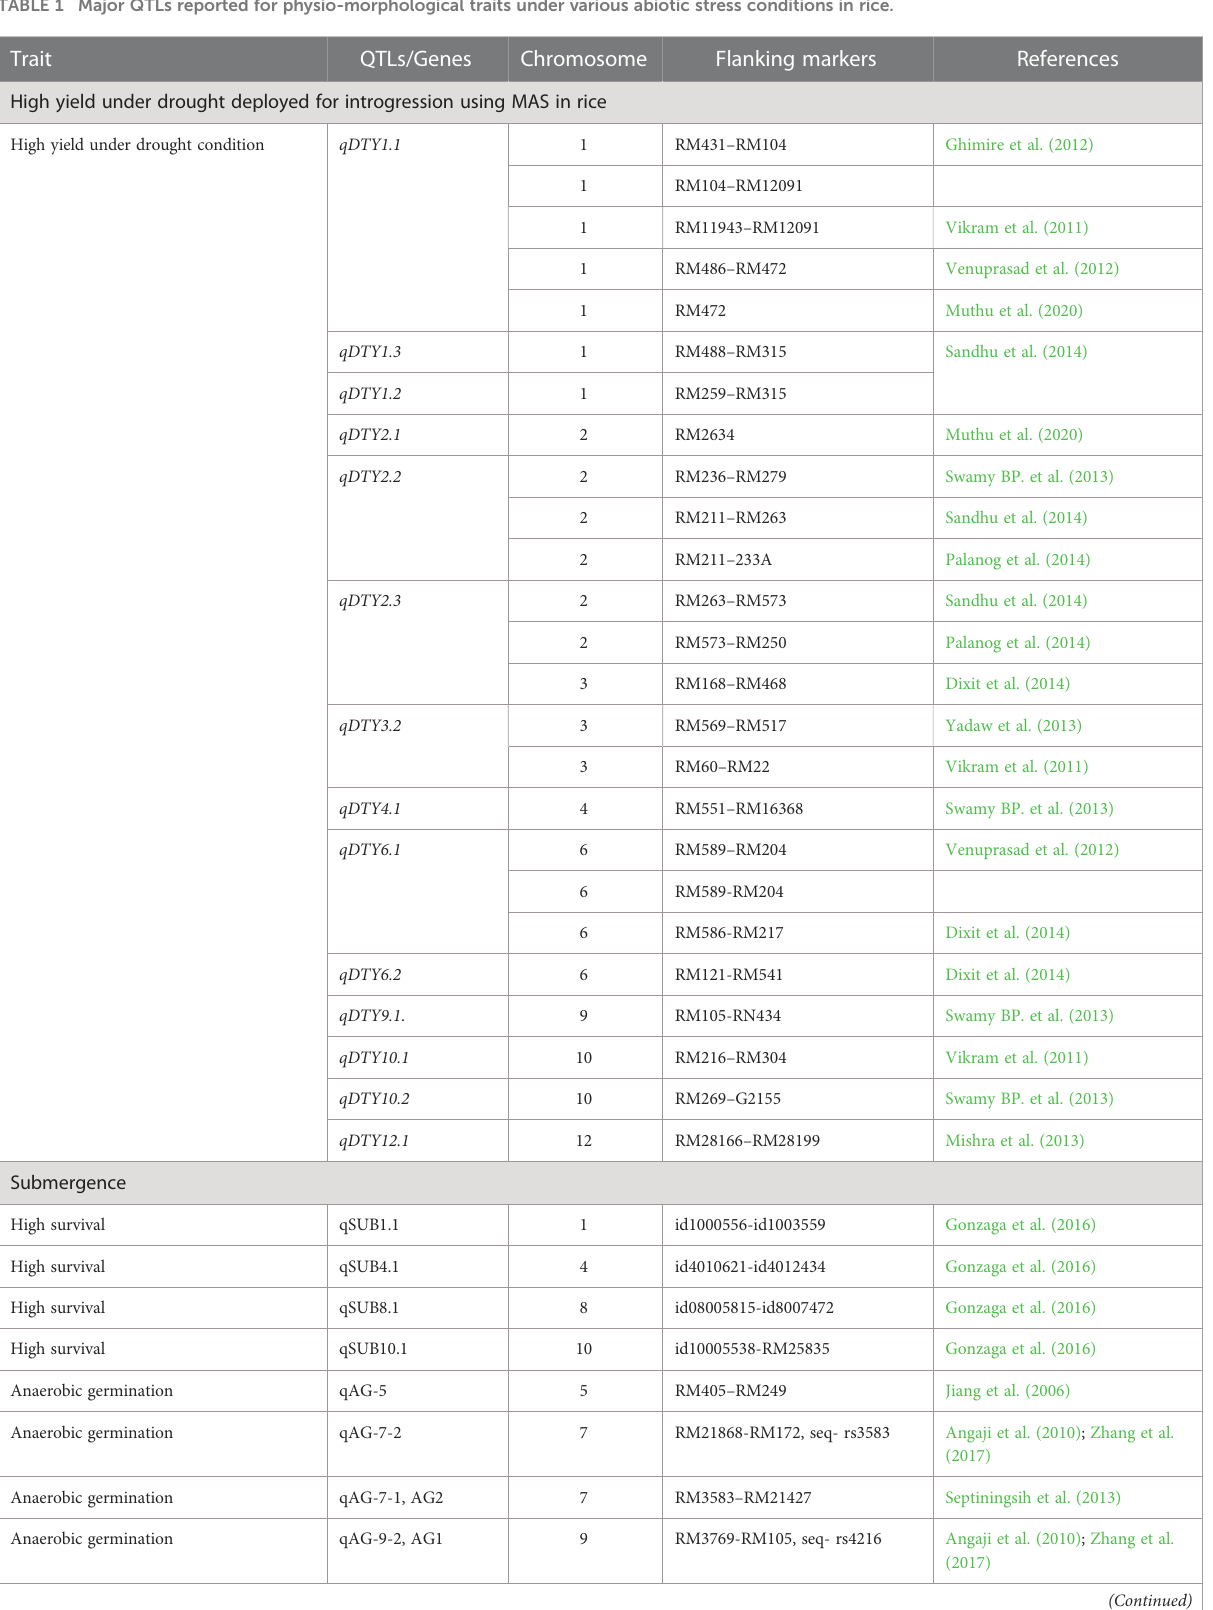
Trait QTLs/Genes Chromosome Flanking